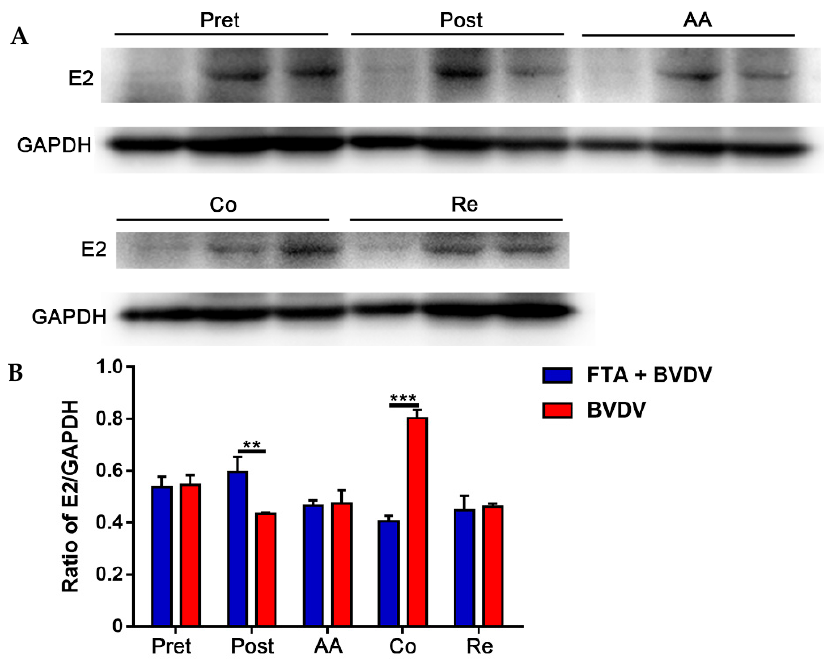
Figure 2. FTA treatment of BVDV infected MDBK cells schemes in the time-of-addition assay. ( A ) Immunoblotting assay was performed to measure the expression of BVDV E2 protein in BVDV- infected MDBK cells treated with FTA under the following conditions: pretreatment, adsorption, posttreatment, cotreatment, and release. ( B ) The protein bands were quantified as the ratio of the intensity of the BVDV E2 protein band to that of the GAPDH band in Western blotting. Data from three independent experiments and error bars are presented as the mean ± SEM. ** p < 0.01, *** p < 0.001.